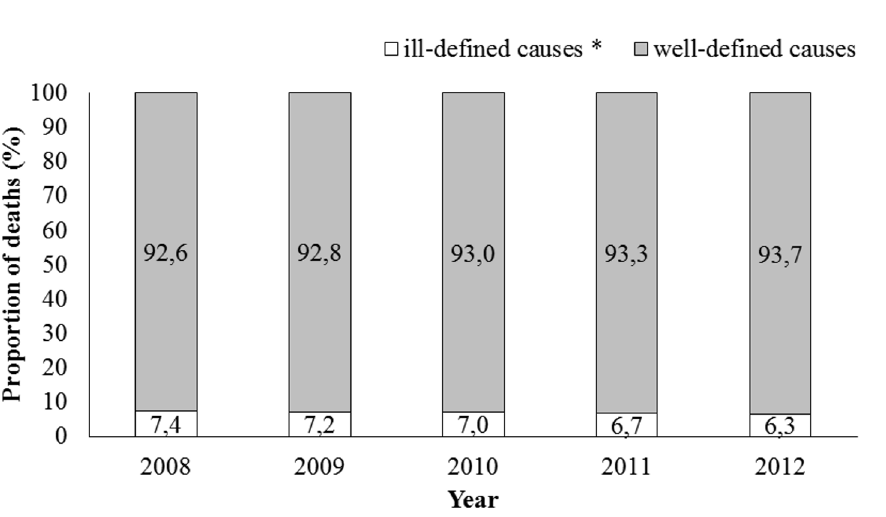
Fig 2. Proportion of deaths from ill-defined causes * of Brazilians between 2008 and 2012. * International classification of diseases, 10th revision. Codes R00 to R99. [11] Source: Mortality Information System (SIM) and Hospital Information System (SIH/SUS). Data made available by the Department of Informatics of The National Health System (DATASUS — www.datasus.gov.br). Ministry of Health, Brazil.